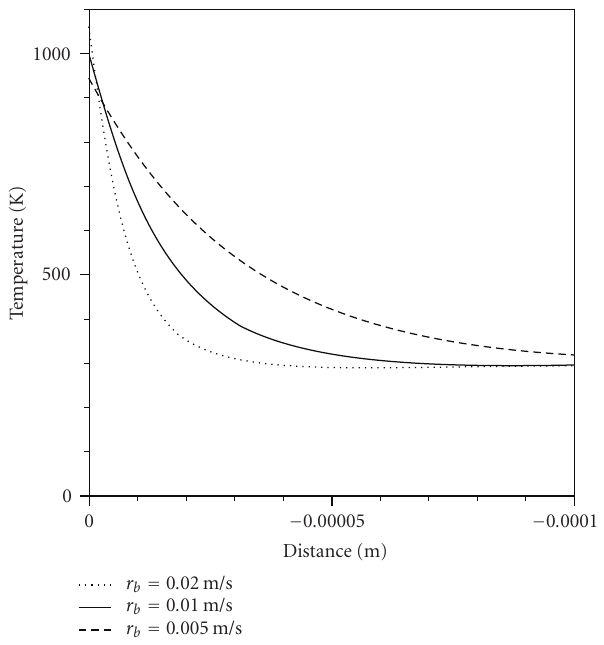
Figure 4: Frequency response of Propellant A, r b , o = 0.01m/s, K b = 170 000 s − 1 , Δ H s =